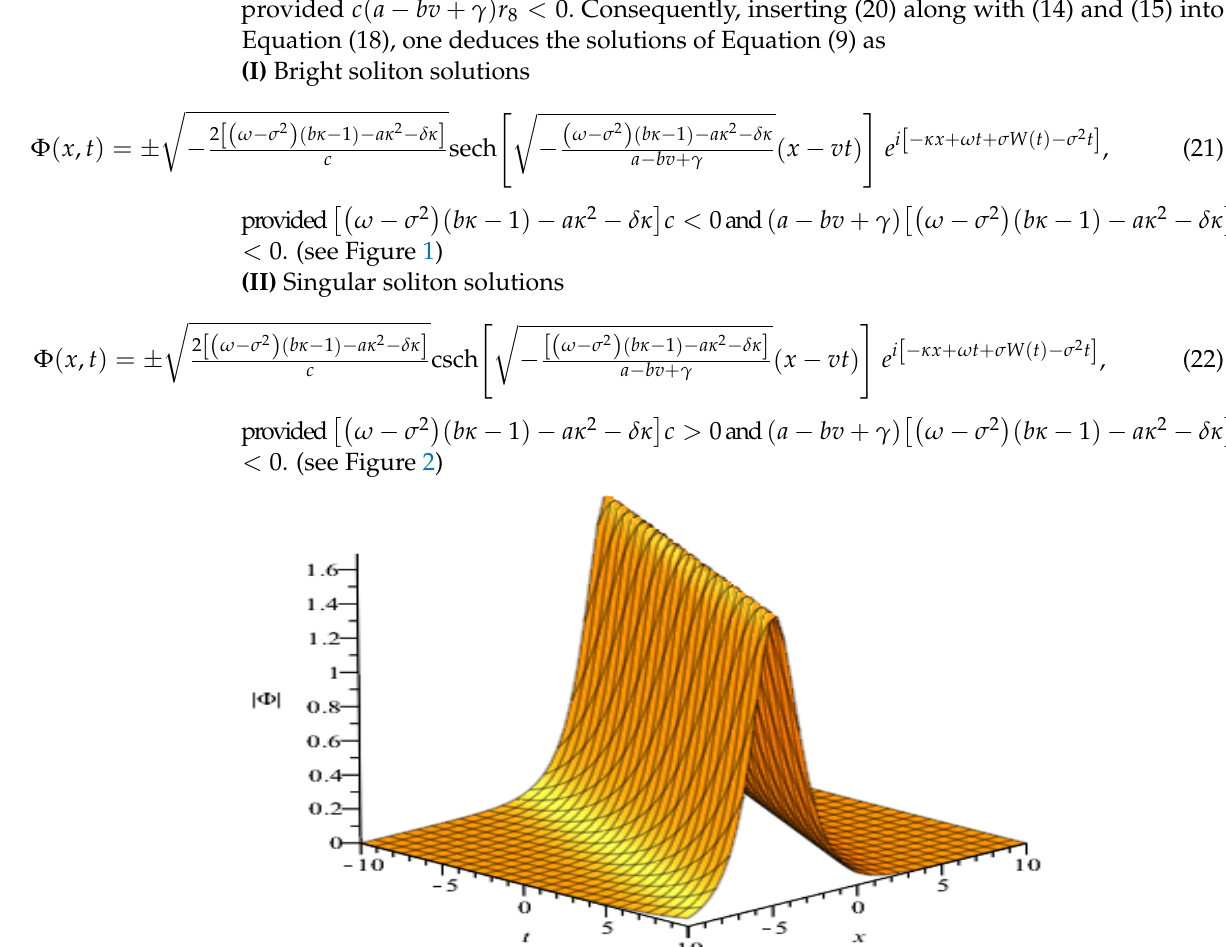
Figure 1. Plot of the bright soliton solution (21) with a = 0.2, b = 0.35, c = 0.4, δ = 0.5, κ = 0.25,